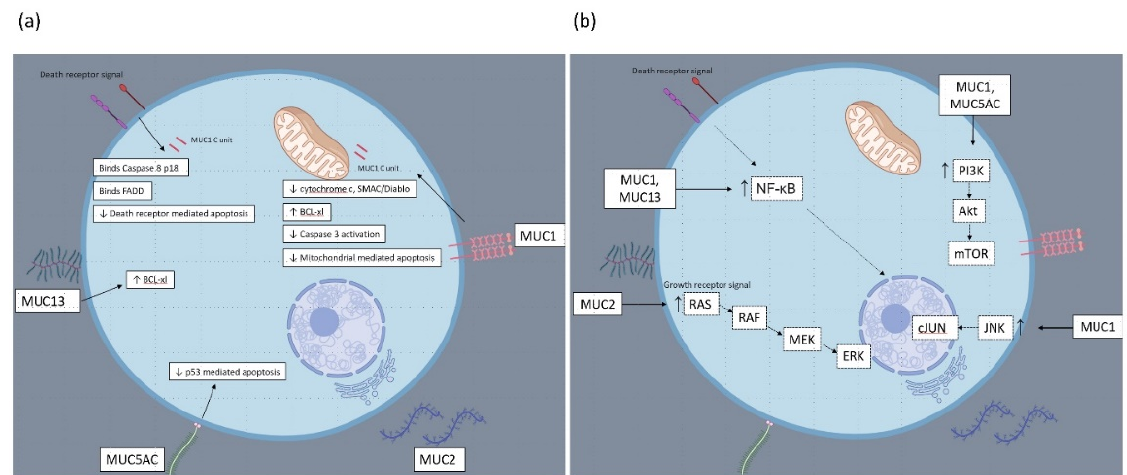
Figure 2. ( a ) Interaction of mucin glycoproteins with apoptosis proteins in colorectal cancer cells. ( b ) Cell survival mechanisms altered by expression of mucin glycoproteins in colorectal cancer cells.